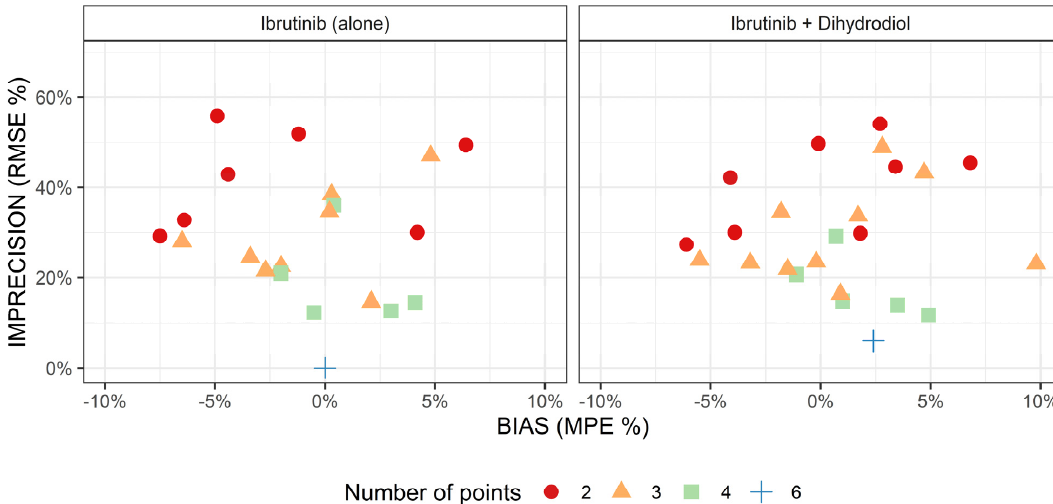
Figure 2. Comparison of the estimation of ibrutinib AUC using ibrutinib concentrations only ( left ) or both ibrutinib and dihydrodiol-ibrutinib ( right ), as a function of the number of points used for estimation (seven values with a bias > 10% are out of bounds). MPE: mean percentage error; RMSE: Root-Mean-Square Error.